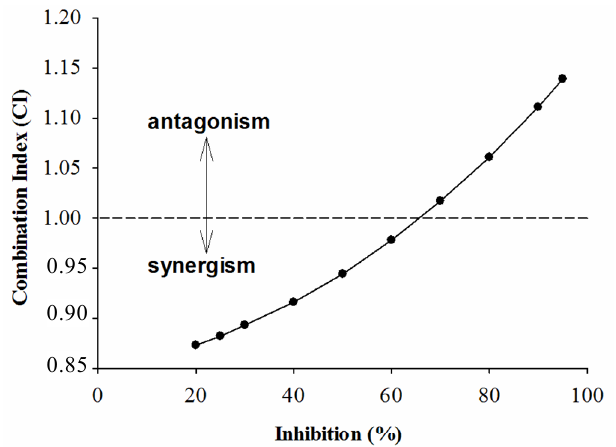
Figure 2. The CI of interaction between GTP and acarbose on α -glucosidase.